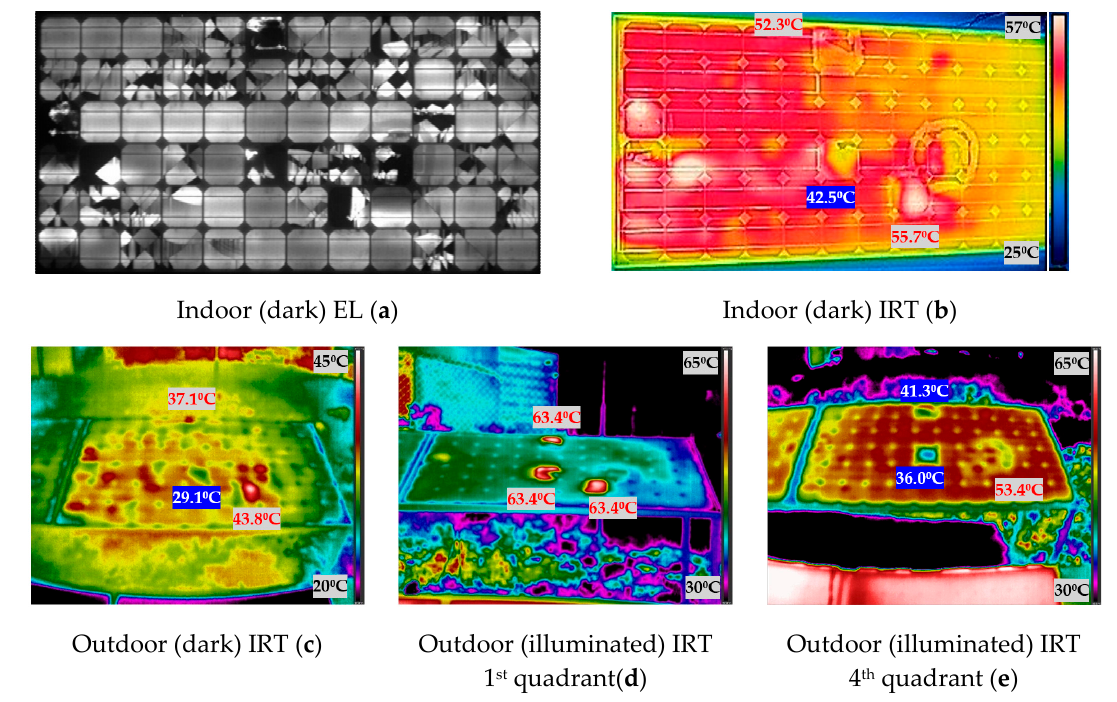
Figure 12. Indoor and outdoor characterization images of module 4: ( a ) indoor (dark) EL; ( b ) indoor (dark) IRT; ( c ) outdoor (dark) IRT; ( d ) outdoor (illuminated) IRT first quadrant; ( e ) outdoor (illuminated) IRT fourth